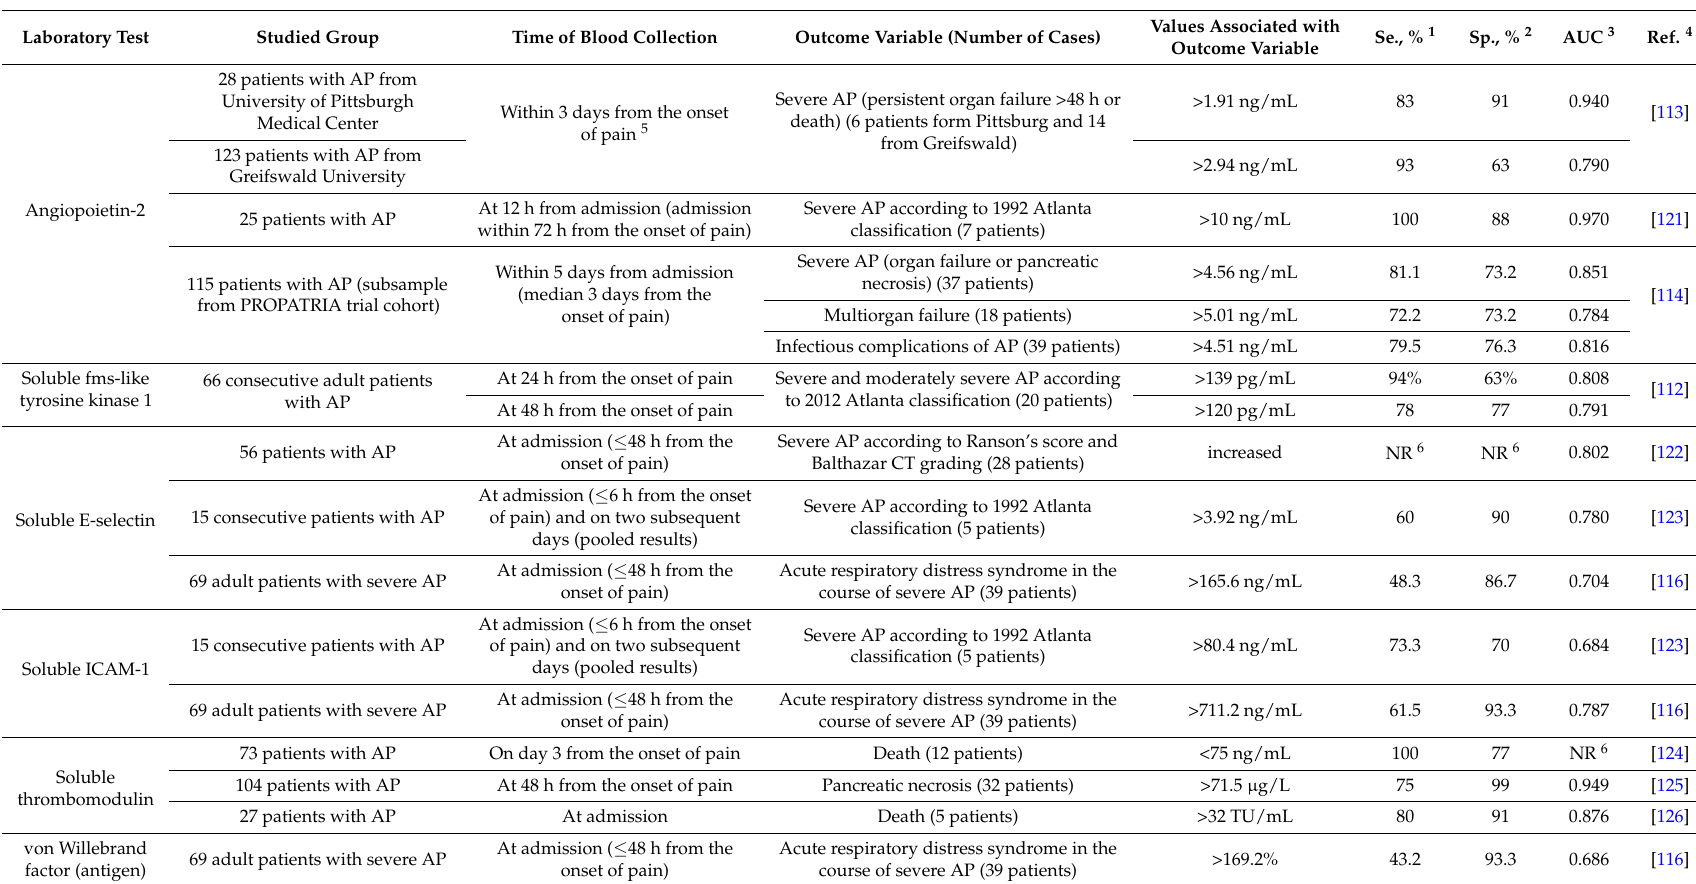
Table 1. Diagnostic accuracy of laboratory markers of endothelial activation or injury measured in serum or plasma for the prediction of severity, complications and mortality of acute pancreatitis